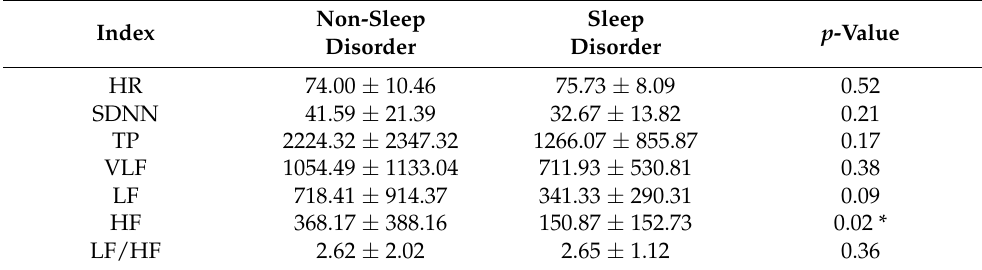
Table 2. HRV parameters.